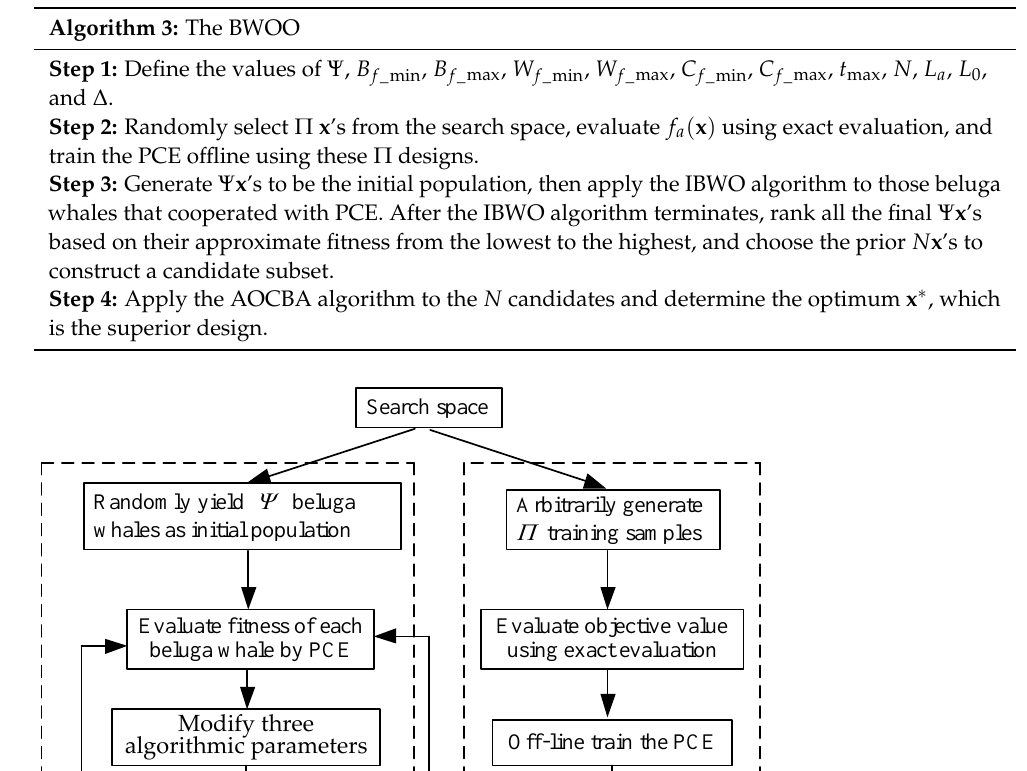
Algorithm 3: The BWOO